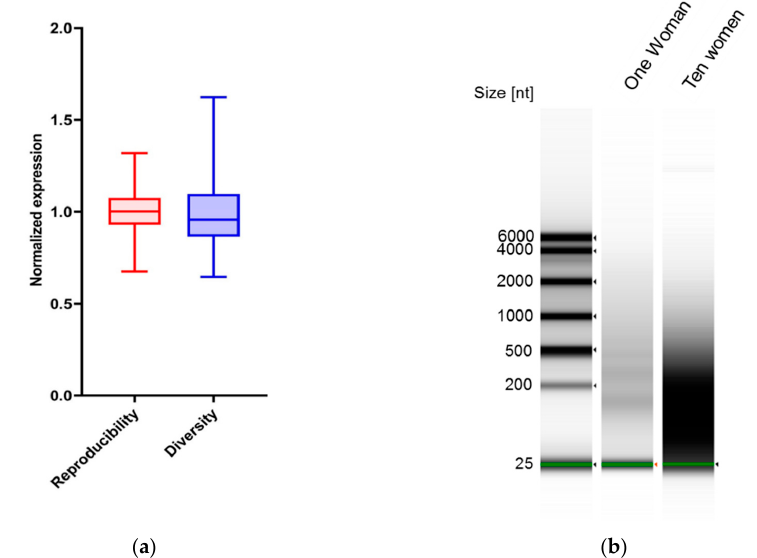
Figure 2. Reproducibility and diversity of splicing factor transcripts in cell-free saliva. For the reproducibility measurement, RNA was extracted from cell-free saliva from the same woman on di ff erent days. Diversity was measured by the extraction of RNA from ten di ff erent menstruating women with ages ranging from 20 y to 50 y ( a ) Real-time PCR was conducted for HNRNPA1, HNRNPA2B1, HNRNPA3, HNRNPK, HNRNPK exon 8 inclusion, PTBP1 and SRSF6 and normalized to PPIA. Relative expression levels were summed and plotted. ( b ) RNA from diversity and reproducibility groups was pooled and visualized on an Agilent